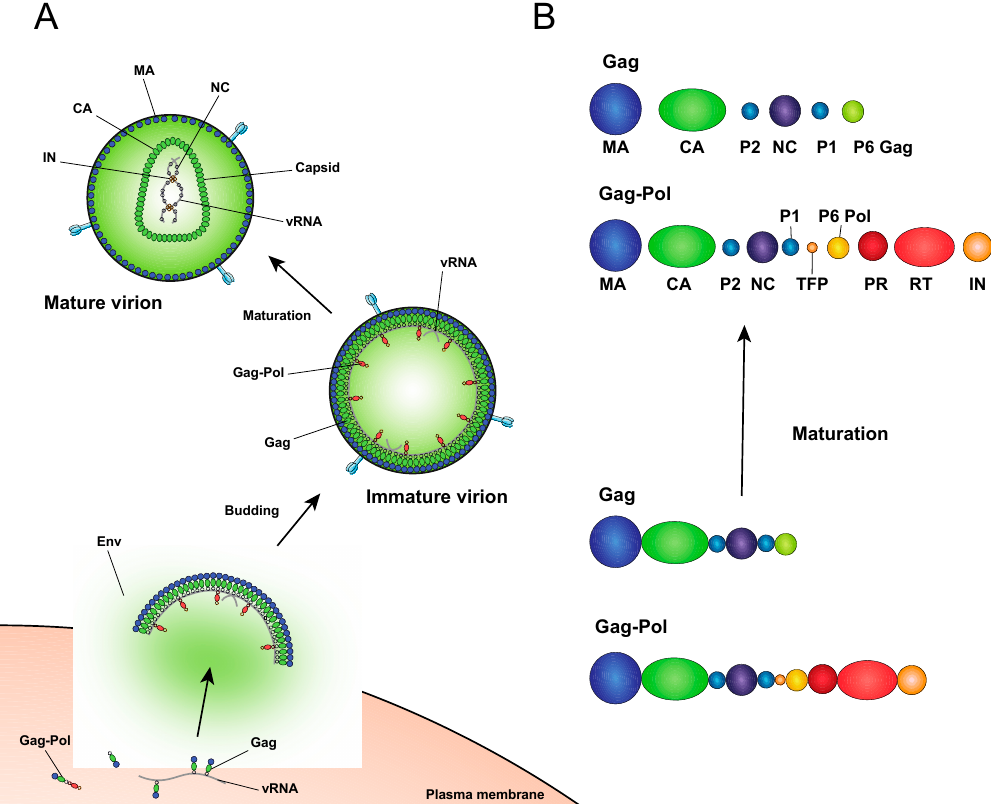
Figure 2. Virion maturation and morphogenesis. ( A ) The Gag and Gag-Pol polyproteins assemble with vRNA at the plasma membrane, bud from the surface of the cell as immature virions, and then undergo a maturation process. ( B ) During maturation PR cleaves Gag and Gag-Pol into independent structural and replicative proteins.